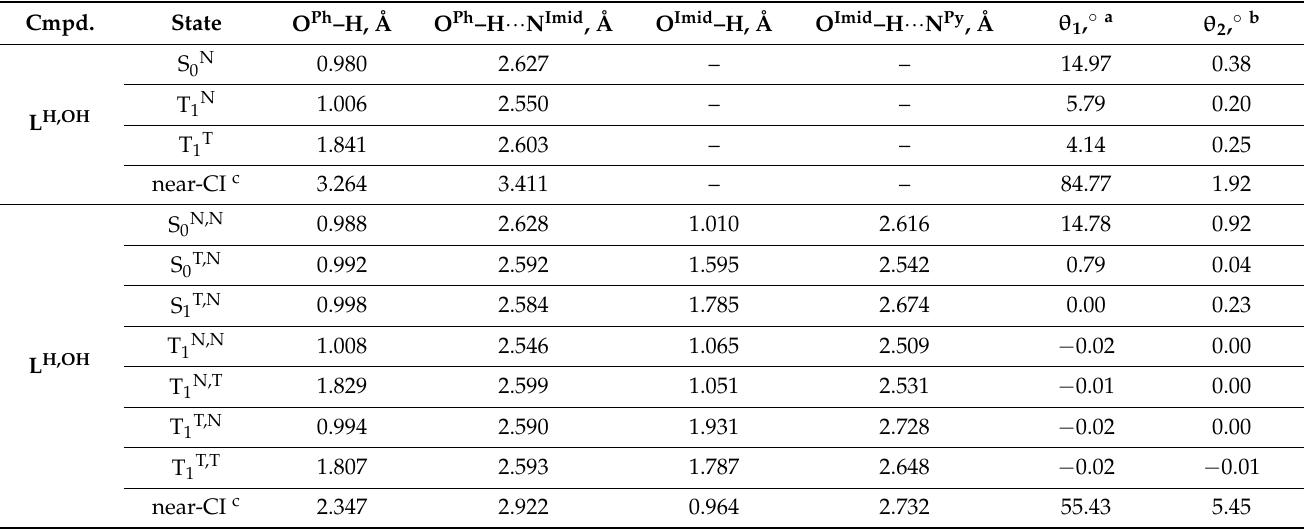
Figure 3. Absorption spectra of L H,OH (red) and L OH,OH (blue) in MeCN. Vertical bars display the positions and oscillator strengths of the singlet-to-singlet electronic transitions for L H,OH (red) and L OH,OH (blue). Table 1. The most relevant geometric parameters for the optimized ground and excited state geom- etries of L H,OH and L OH,OH .